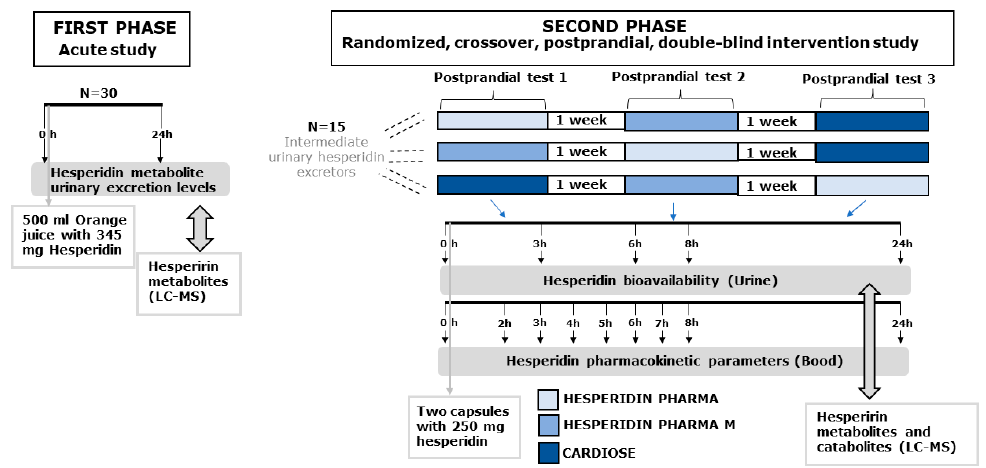
Figure 1. Schematical representation of the clinical